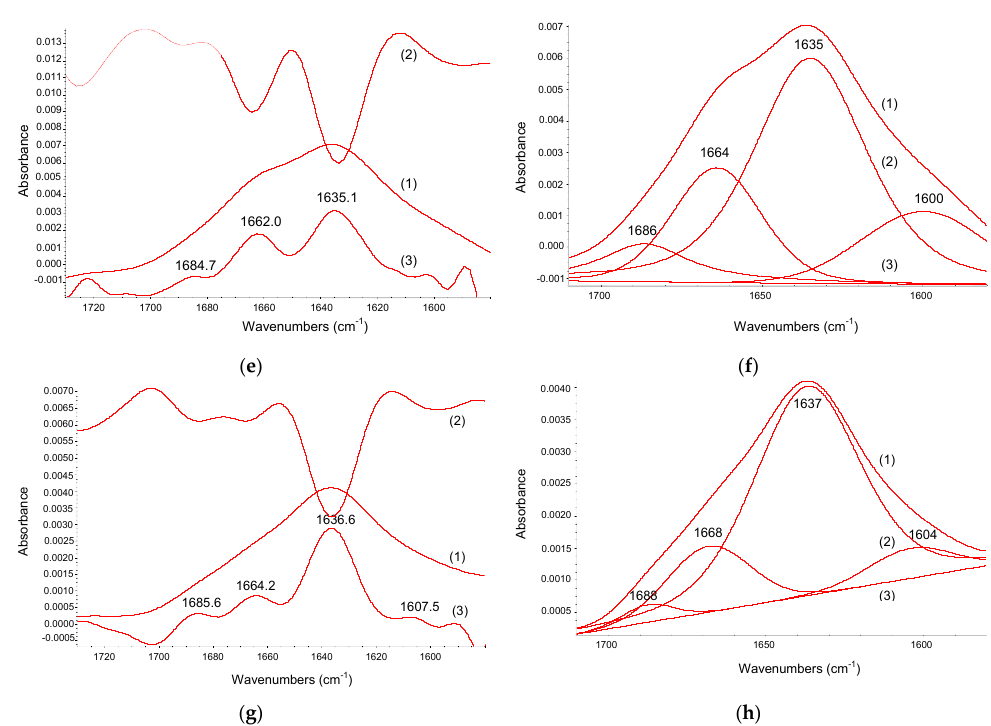
Figure 3. IVIG FT-IR spectra and the curve-fitting procedures of amide I band in the presence of 7-ethylcamptothecin at 296 K. The concentration of IVIG is 2.0 μ M. ( a , b ) The concentration of 7-ethyl-camptothecin is 4.0 μ M at pH 4.0; ( a ) (1), (2) and (3) represent the difference spectra, second derivative resolution enhancement and self-deconvolution, respectively; ( b ) (1), (2) and (3) represent the difference spectra, curve-fitting results and curve-fitting baseline, respectively. The means represented by numbers (1, 2, 3) in parentheses in figures of ( c , e , g ) are the same as those in ( a ), and the means represented by numbers (1, 2, 3) in the figures of ( d , f , h ) are the same as those in ( b ). ( c , d ) The concentration of 7-ethylcamptothecin is 8.0 μ M at pH 4.0; ( e , f ): The concentration of 7-ethylcamptothecin is 4.0 μ M at pH 7.4; ( g , h ) The concentration of 7-ethylcamptothecin is 8.0 μ M at pH 7.4. Table 3. The secondary structural composition of free IVIG and its six camptothecin analogue complexes estimated by FT-IR difference spectra, self-deconvolution, second derivative resolution enhancement and the curve-fitting procedures of amide I band at 296 K. The concentration of IVIG is 2.0 µ M [43–45]. pH Amide I components (%)